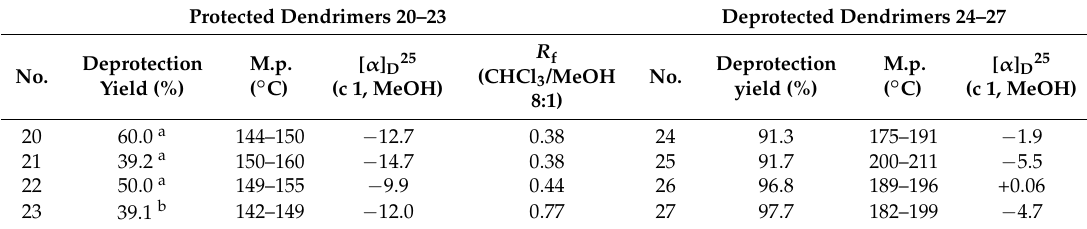
Table 1. Physicochemical data for dendrimers